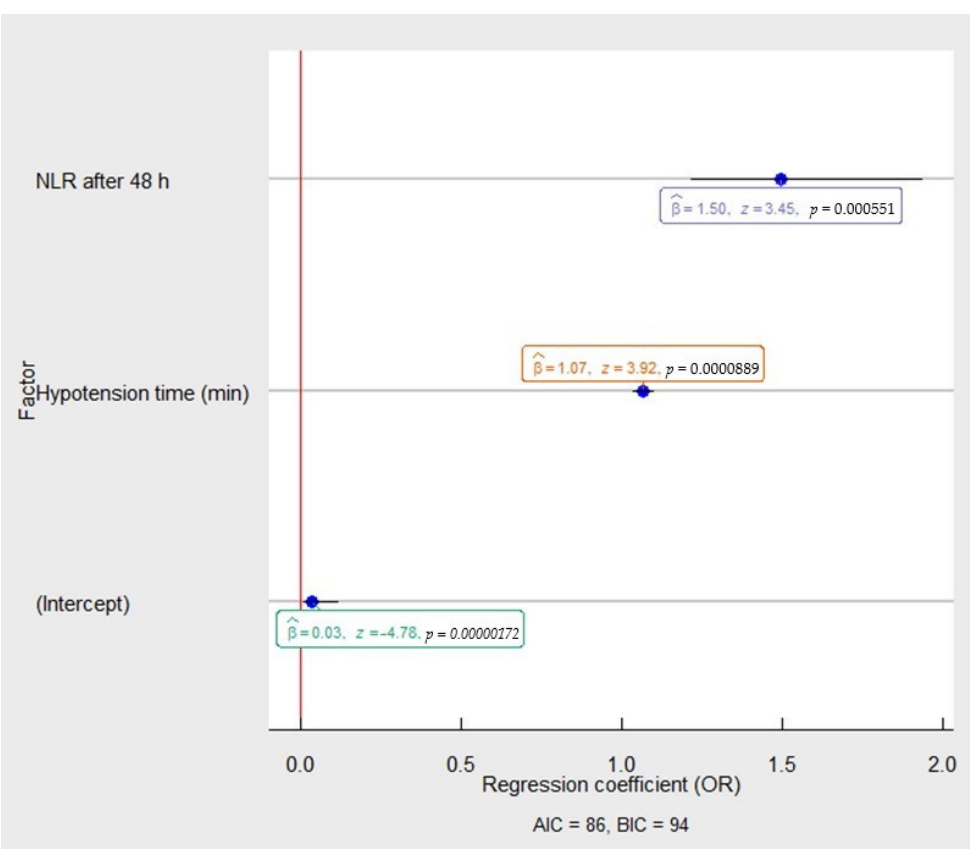
Figure 2. The multivariable analysis of risk factors associated with postoperative AKI in the patients after partial nephrectomy. The OR and 95% CI were measured through logistic regression. Model characteristics: X 2 = 43.56, p = 0.00; Pseudo − R² (Cragg–Uhler) = 0.51; Pseudo − R² (McFadden) = 0.35. Abbreviations: NLR − neutrophil to lymphocyte ratio; OR-odds ratio: AIC − Akaike information criteria; BIC − Bayesian information criteria.